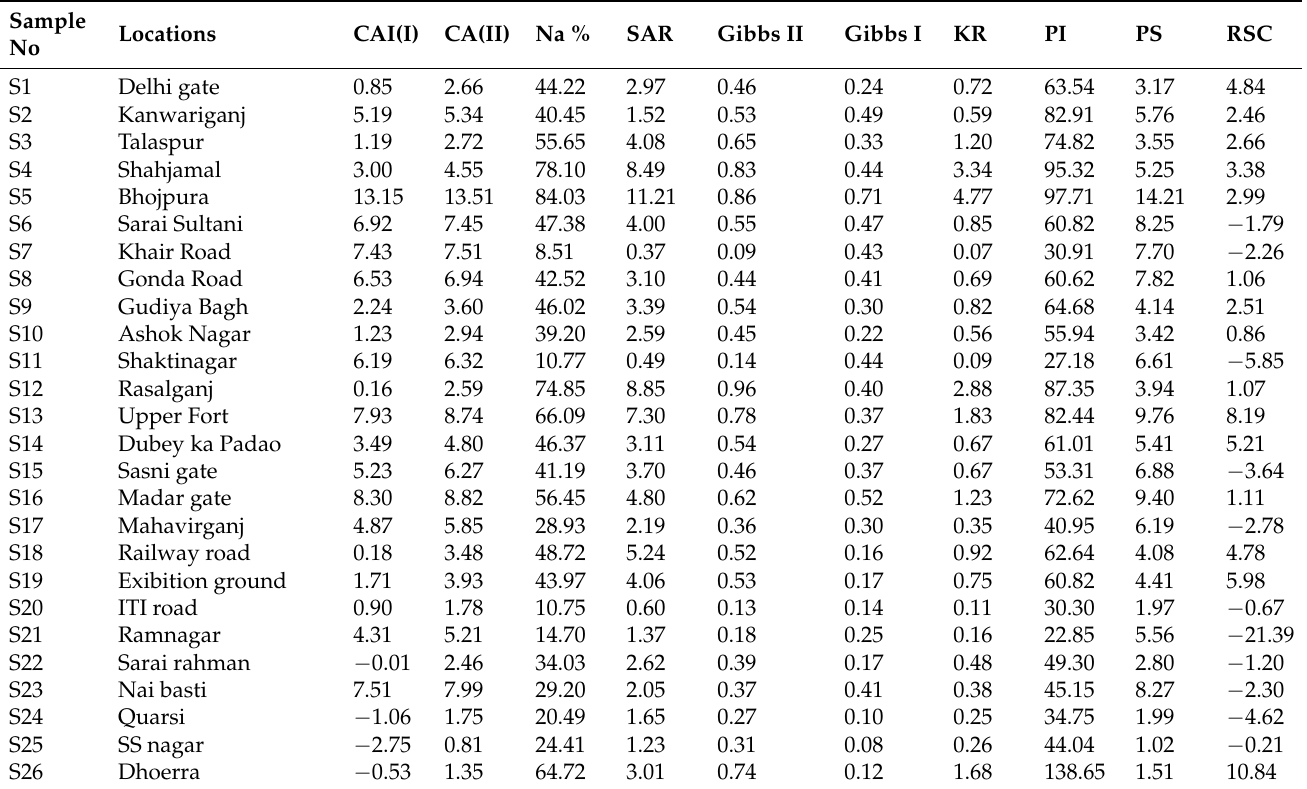
Table 3. Different index values for irrigation purposes in the study